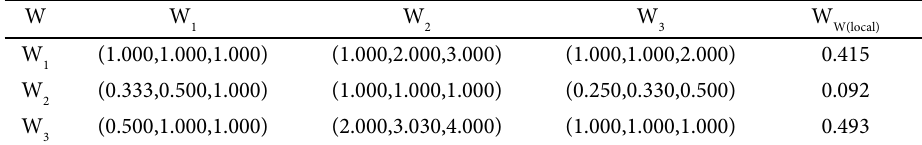
Table 8. Pair-wise comparison matrices and local weights for “W”-group factors